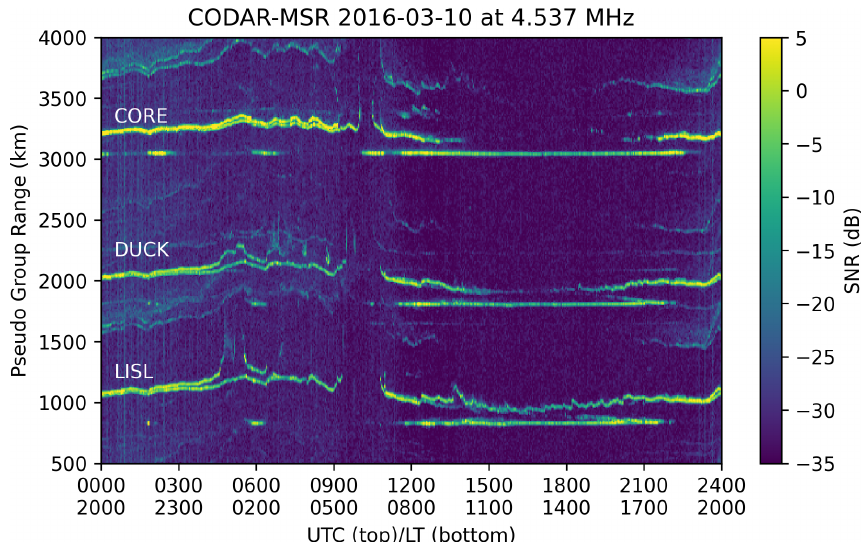
Figure 2. A 24h (pseudo) range–time–intensity (RTI) plot from three ocean wave radar transmitters received at MSR at 4.53718MHz on 10 March 2016. The pseudo-group ranges corresponding to the LISL, DUCK, and CORE CODAR transmitters are listed. The figures are plotted with respect to UTC, but Eastern Time (LT) is also shown for reference. See the text for further discussion.